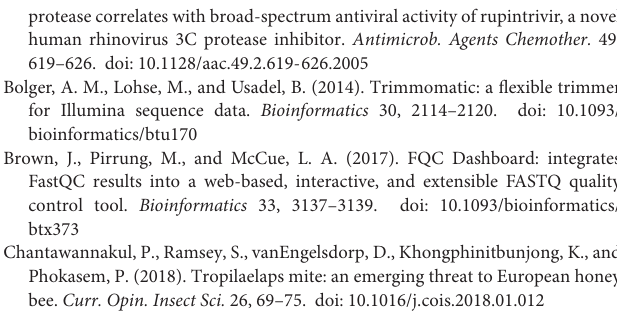
Supplementary Figure 1 | Principal component analysis of four RNA-seq samples. Two RNA-seq samples each for pale eyes- (red circle) and brown thorax- (blue circle) pupae were analyzed by principal component analysis. Two samples cluster together in each group. Supplementary Figure 2 | Heatmap of the differentially expressed genes between the heads of pale eyes- and brown thorax-pupae. Expression profiles of 1,861 differentially expressed genes between the heads of pale eyes (#1 and #2)- and brown thorax (#1 and #2)-pupae are shown by the heatmap. The genes are clustered based on the expression profile indicated by the different colors (blue to red). Supplementary Figure 3 | Silver staining of immunoprecipitates by anti-VP1 P-domain antibody. Lysates of DWV-infected pupae were immunoprecipitated by either anti-VP1 P-domain antibody or the pre-immune serum. The eluted immunoprecipitates were separated by 8% SDS-PAGE and then processed for silver staining. Four major bands specifically immunoprecipitated by anti-VP1 P-domain antibody were identified to be VP1, VP2, and VP3 by the mass spectrometry analysis. VP2 and VP3 present in DWV virion were co-immunoprecipitated with VP1. The size (kDa) of protein molecular weight